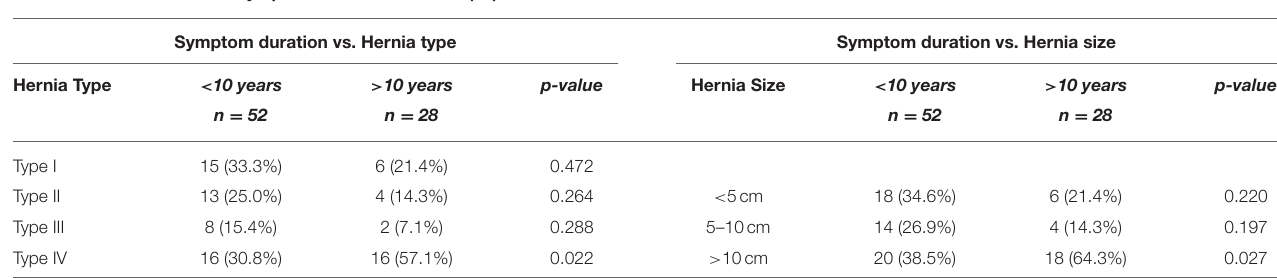
TABLE 5 | Subjective symptoms related to hiatal hernia